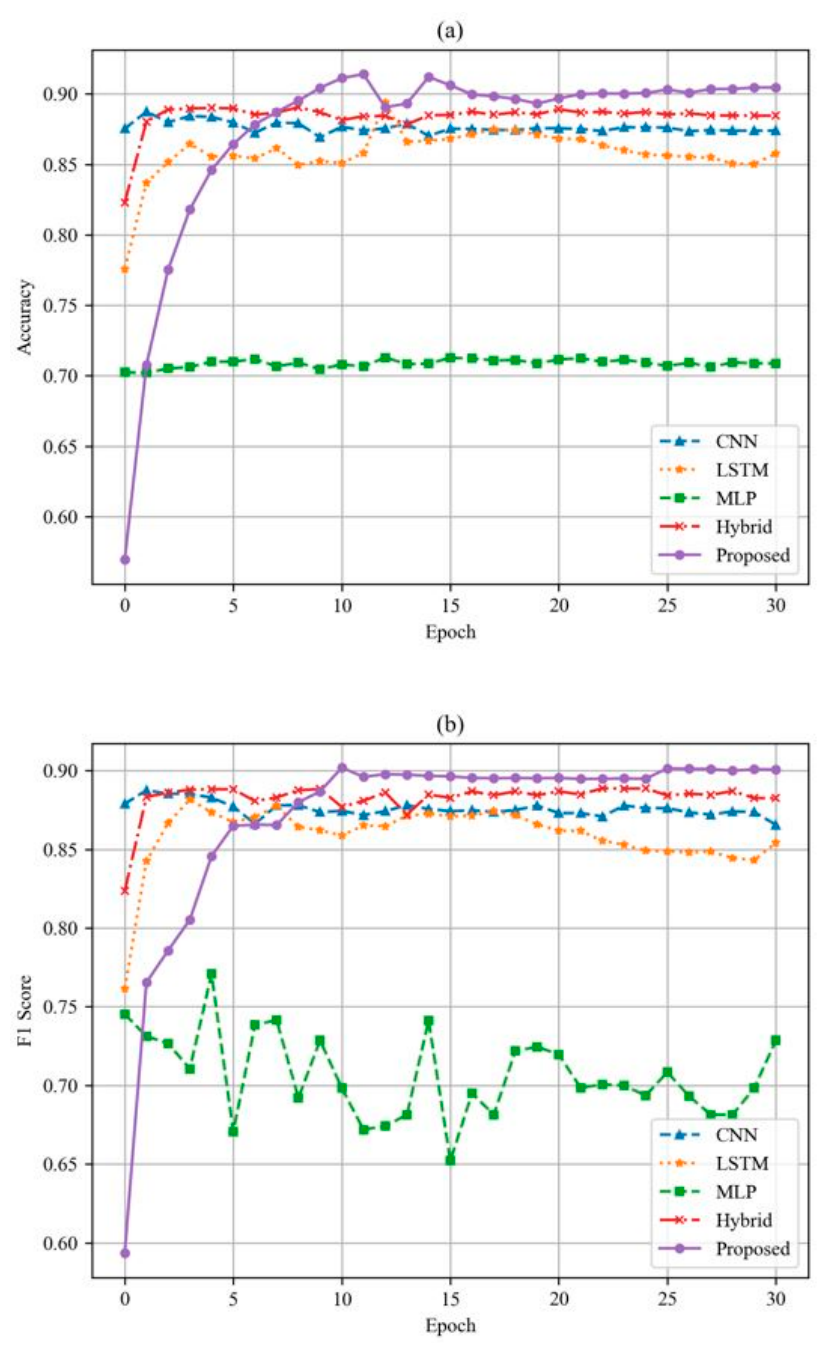
Figure 5. Model performance as the number epochs increases: ( a ) Accuracy; ( b ) F1 Score. And the LSTM model shows stable accuracy after 10 k. In the case of the MLP model, it shows that the accuracy between 0.70 and 0.75 is maintained regardless of the data size. Next, in Figure 6b, the models other than MLP show a similar pattern to the accuracy graph, and in the case of MLP, the range of change is very large and it does not show a stable